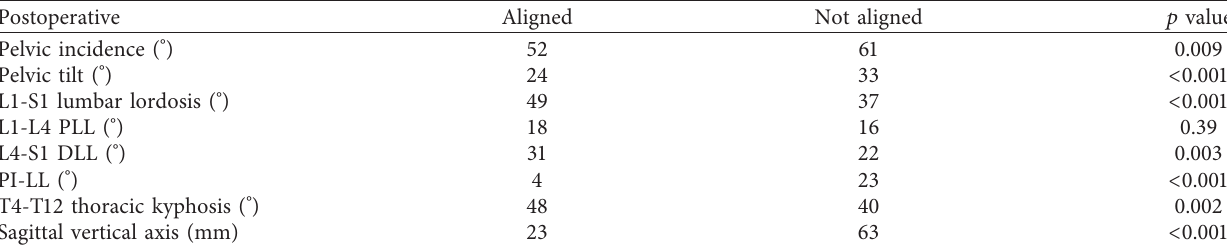
Table 2: Postoperative values of radiographic parameters between “aligned” and “not aligned”